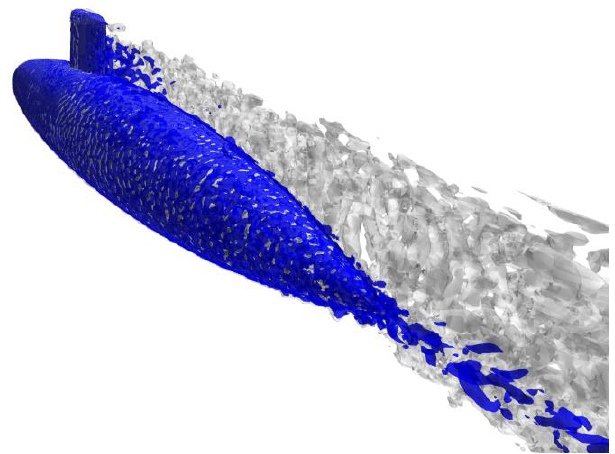
Figure 10. Cloud map of Q-contour surface of underwater vehicle with sail (blue Q = 100 s − 2 gray Q = 1 s − 2 ).